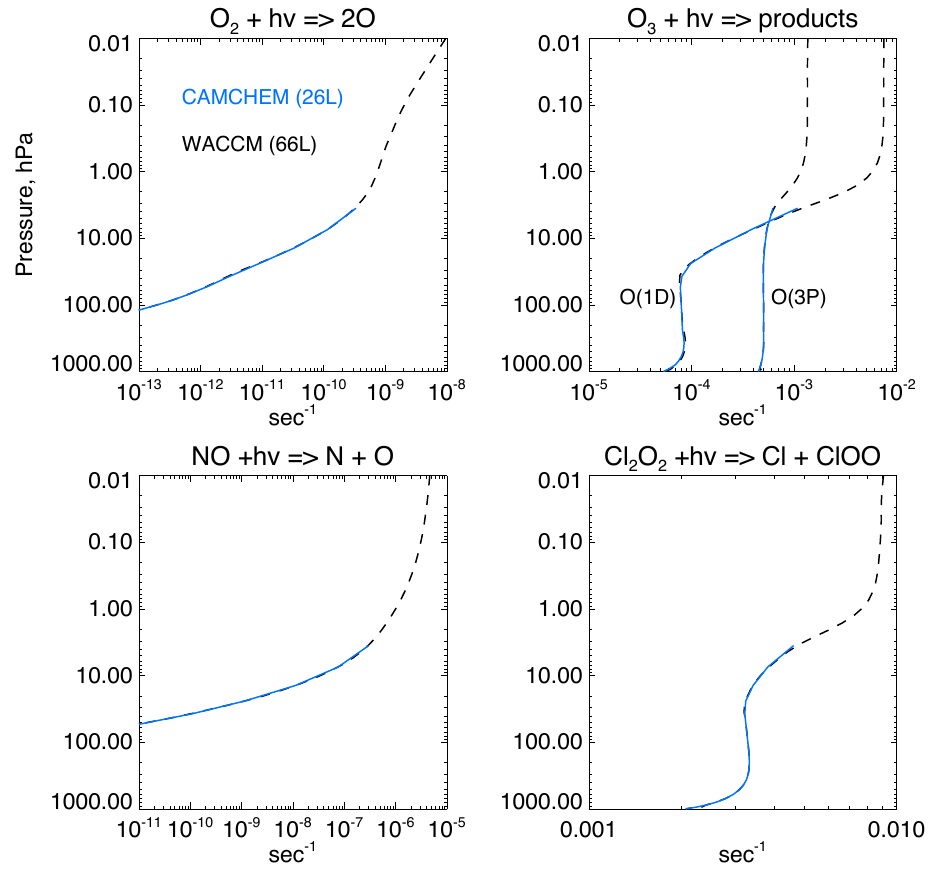
Fig. 2. Photolysis rates in CAM and WACCM for 1 January, noon at 0 ◦ N conditions.